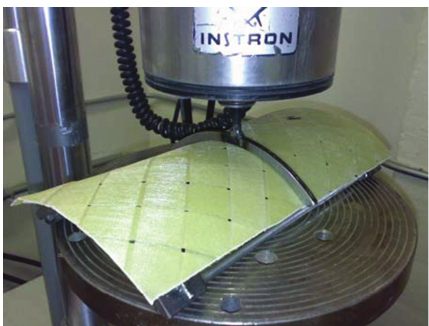
Figure 2: Three-point bending test setup.